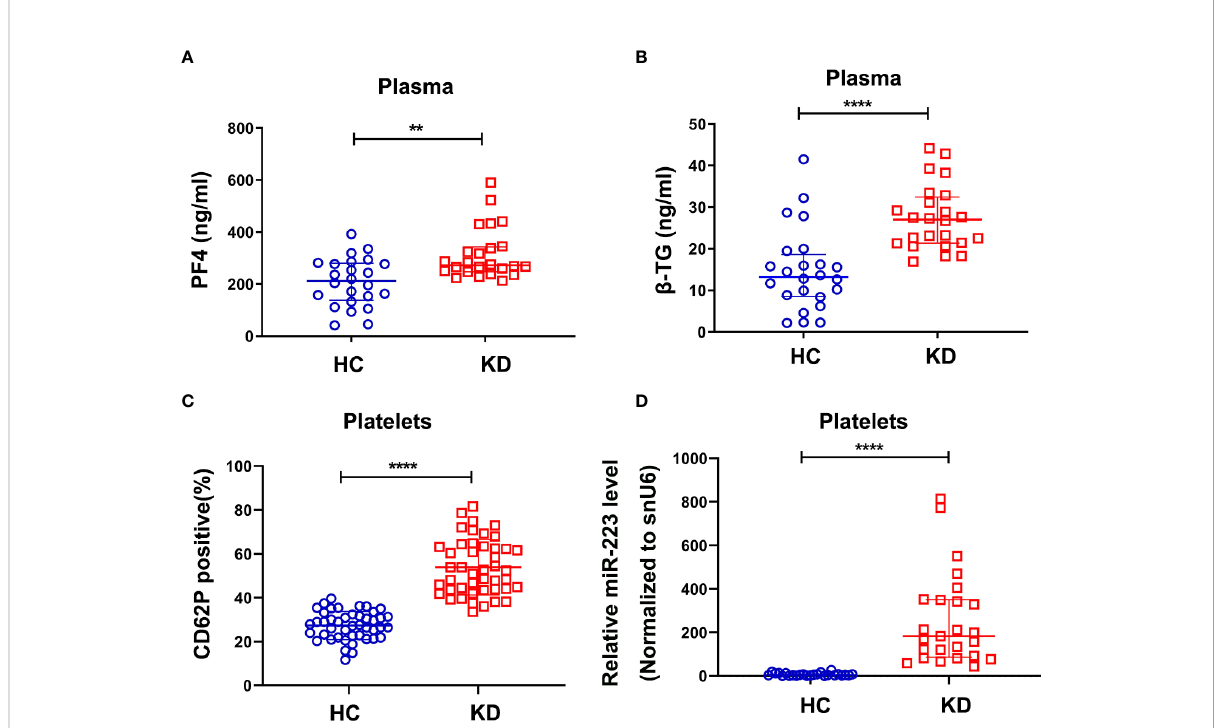
FIGURE 1 KD platelets were hyperactive and exhibit higher expression of miR-223. Plasma levels of PF4 (A) and b -TG (B) in HC and KD groups (HC: n = 24, KD: n = 24). Data are presented as median ± IQR, Mann Whitney test. (C) Surface expression of P-selectin (CD62P) in platelets isolated from HC and KD groups (HC: n = 45, KD: n = 45). Data are presented as mean ± SD, Unpaired t- test. (D) Relative expression of miR-223 in platelets isolated from HC and KD groups (HC: n=25, KD: n=25). Data are presented as median ± IQR, Mann Whitney test. ** P < 0.01, **** P < 0.0001. ns means no statistical